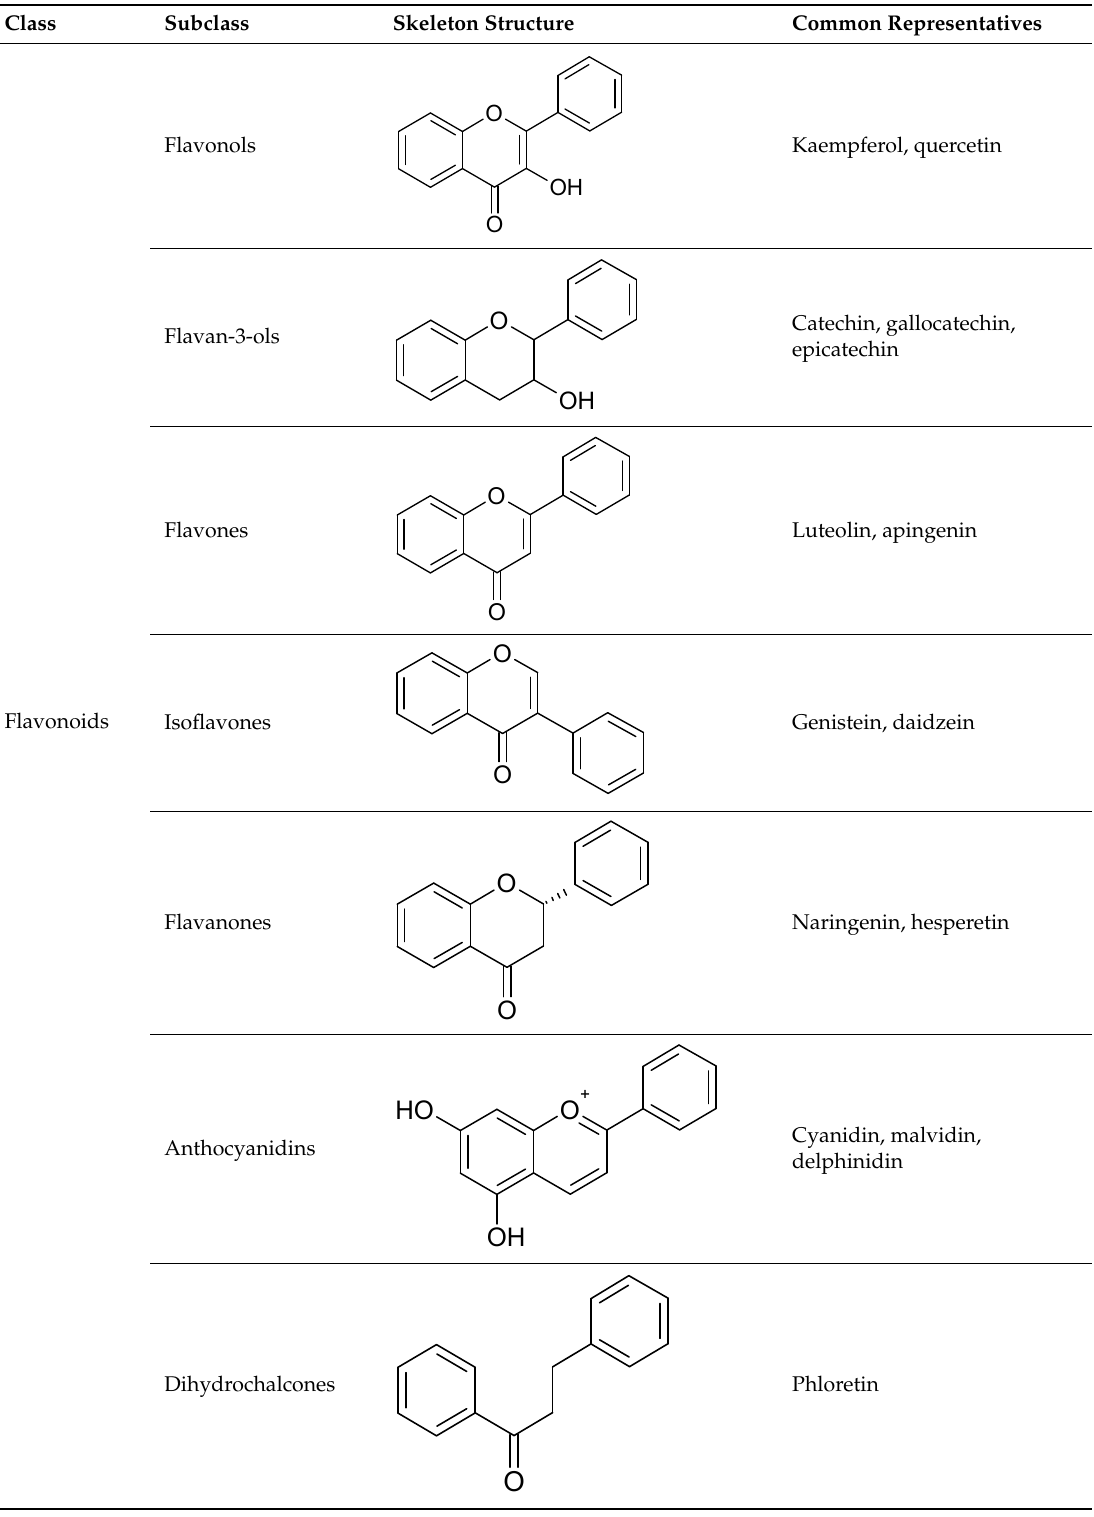
Table 1. Major classes of dietary phenolic compounds, skeleton structure thereof and common representatives.